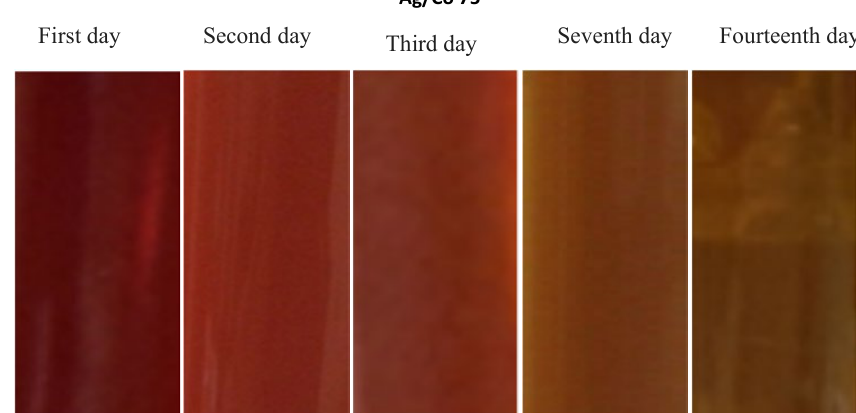
Fig. 3: Silver-cobalt nanoparticles produced from silver nanoparticles at different times of 75 seconds on the first, second, third, seventh and fourteenth days (respectively, from left to right). As shown in Fig. 4, the absorption spectrum of silver-cobalt nanoparticles prepared from silver nanoparticles synthesized at a time interval of 75 seconds, after a few days, relatively small broadening with low displacement to lower wavelengths observed it turned out. The solution color of these nanoparticles is slightly altered and the solution is deposited, the absorption spectrum of these nanoparticles is about 425 nm.